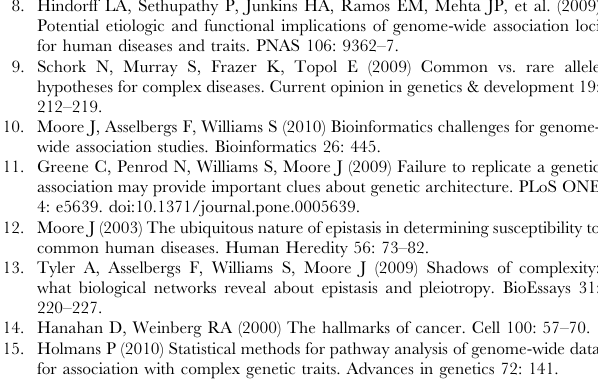
Table S1 Full list PID pathways with significant DS P in the breast cancer GWAS, including highly ‘‘overlapping’’ pathways. Pathway-length based resampled p -values, denoted p ( DS P ) , are given for significant pathways, along with the odds ratios and associated FDRs for a logistic regression model. Table S2 Full list PID pathways with significant DS P in the liver cancer GWAS, including highly ‘‘overlapping’’ pathways. Path- way-length based resampled p -values, denoted p ( DS P ) , are given for significant pathways, along with the odds ratios and associated FDRs for a logistic regression model.